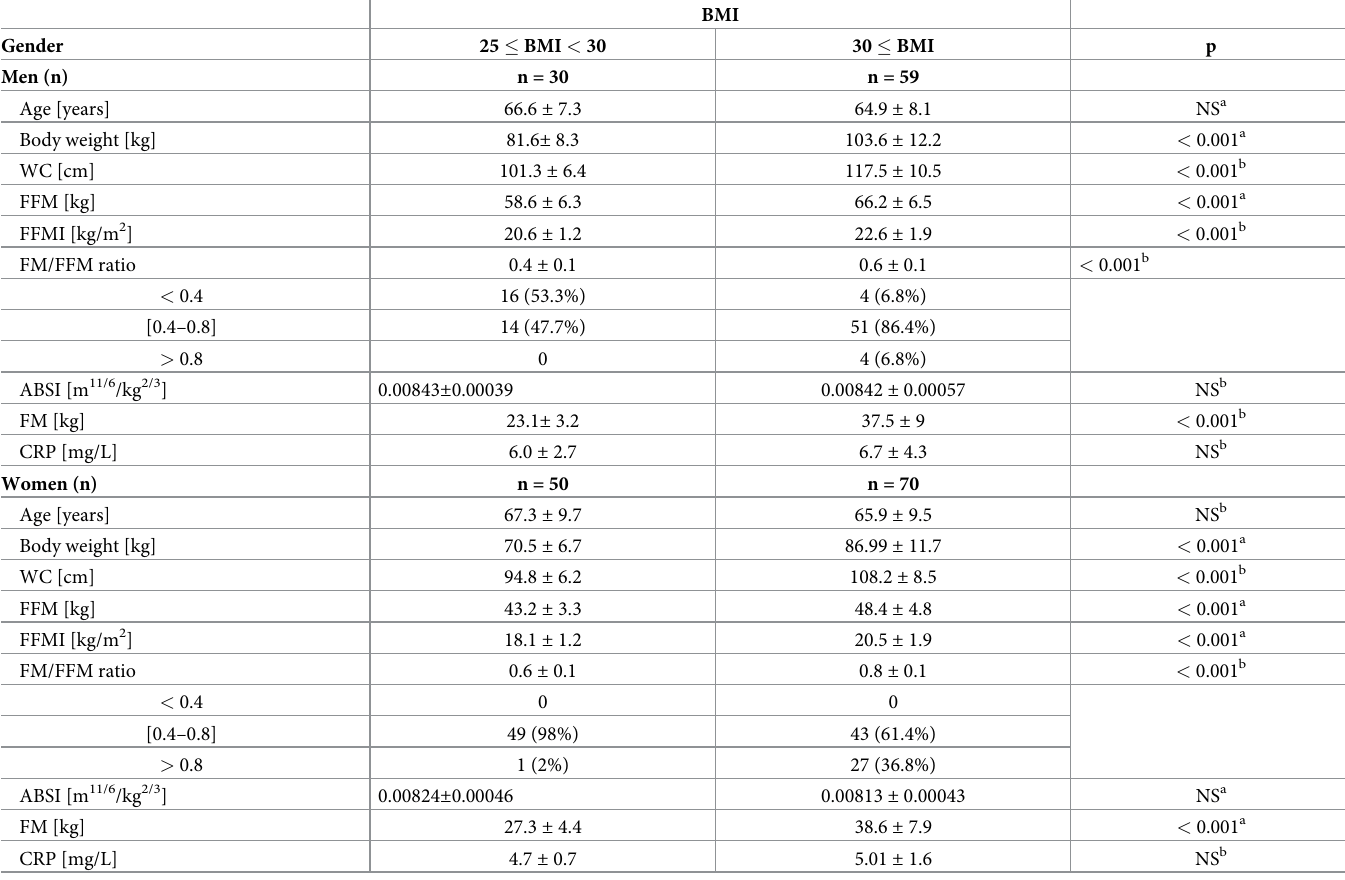
Table 2. Anthropometric, body composition and other measured parameters of overweight and obese